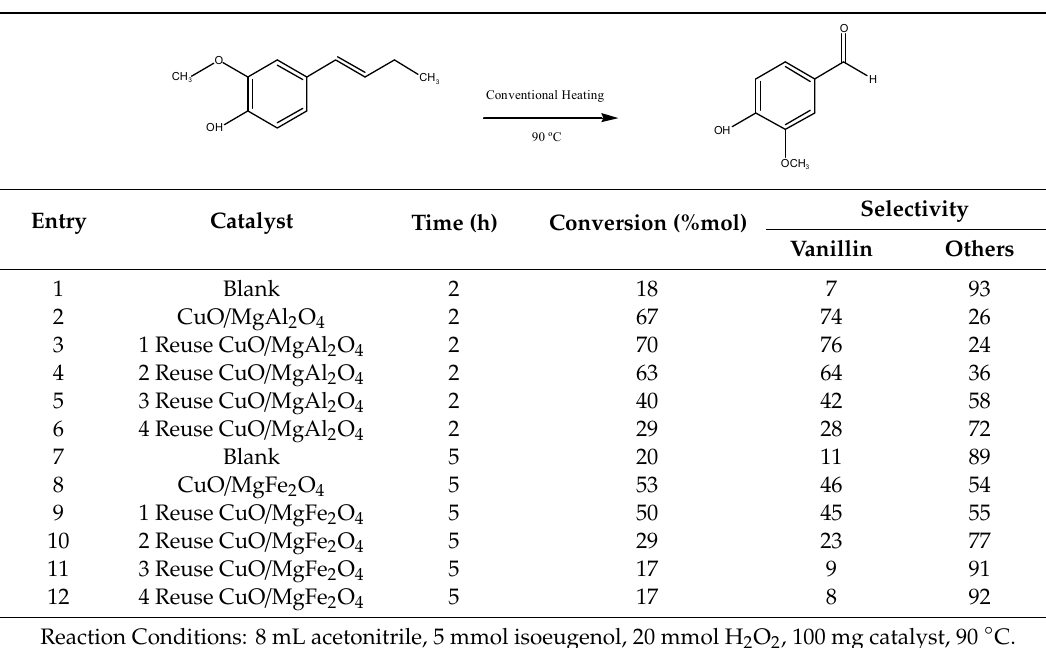
Table 3. Catalytic activity of CuO/MgAl 2 O 4 and CuO/MgFe 2 O 4 catalysts in the oxidation of isoeugenol to vanillin.